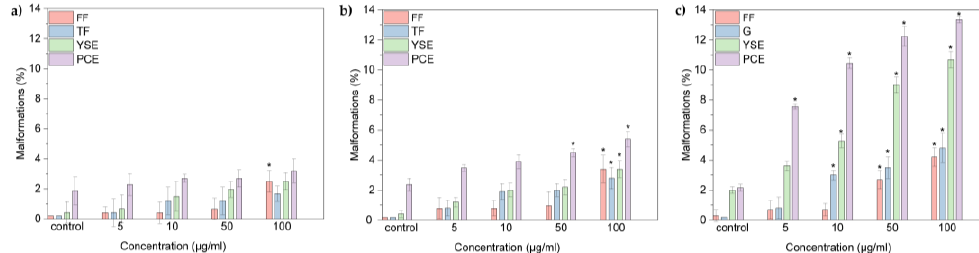
Figure 8. Malformation of larvae at 96 hpf treated with ( a ) oxi-CNOs, ( b ) oxi-CNHs and ( c ) GO. FF, fin fold flexure; TF, tail flexure; YSE, yolk sac edema; PCE, pericardial edema.